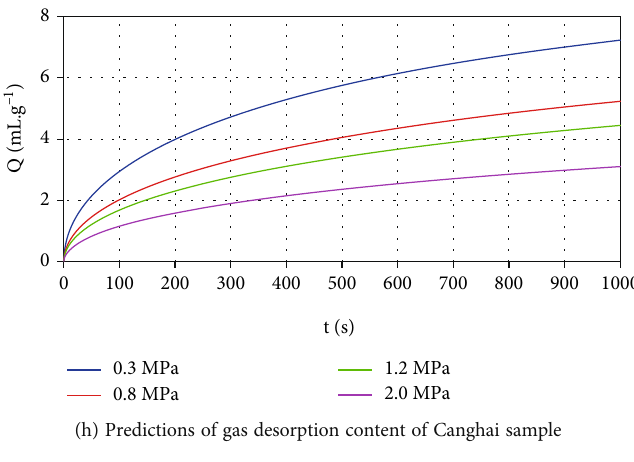
Figure 9: Results of numerical